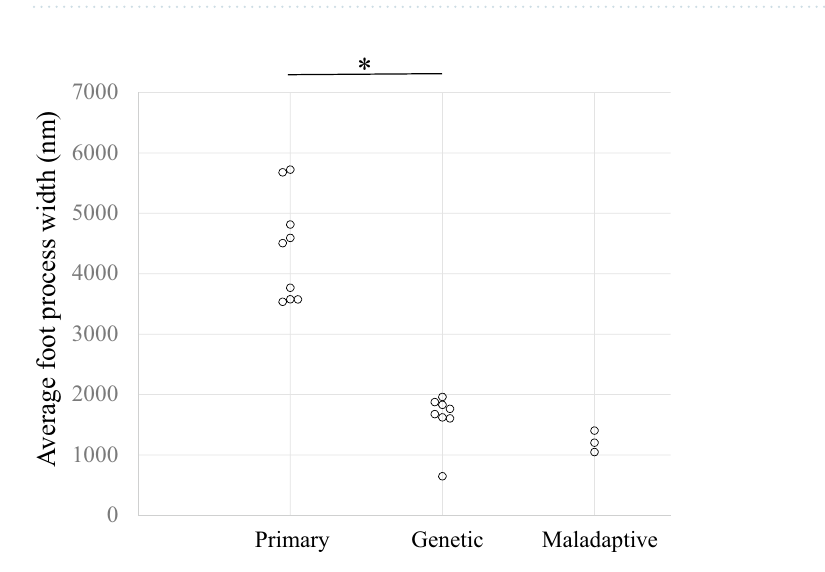
Figure 2. Foot process width of patients with primary, genetic and maladaptive FSGS patients. Median FPW was 4504 nm (range, 3534–5722 nm), 1719 nm (range, 647–1960 nm), and 1203 nm (range, 1047–1402 nm) in primary, genetic, and maladaptive FSGS patients, respectively. FPW was significantly larger in primary FSGS patients than in genetic FSGS patients ( p =